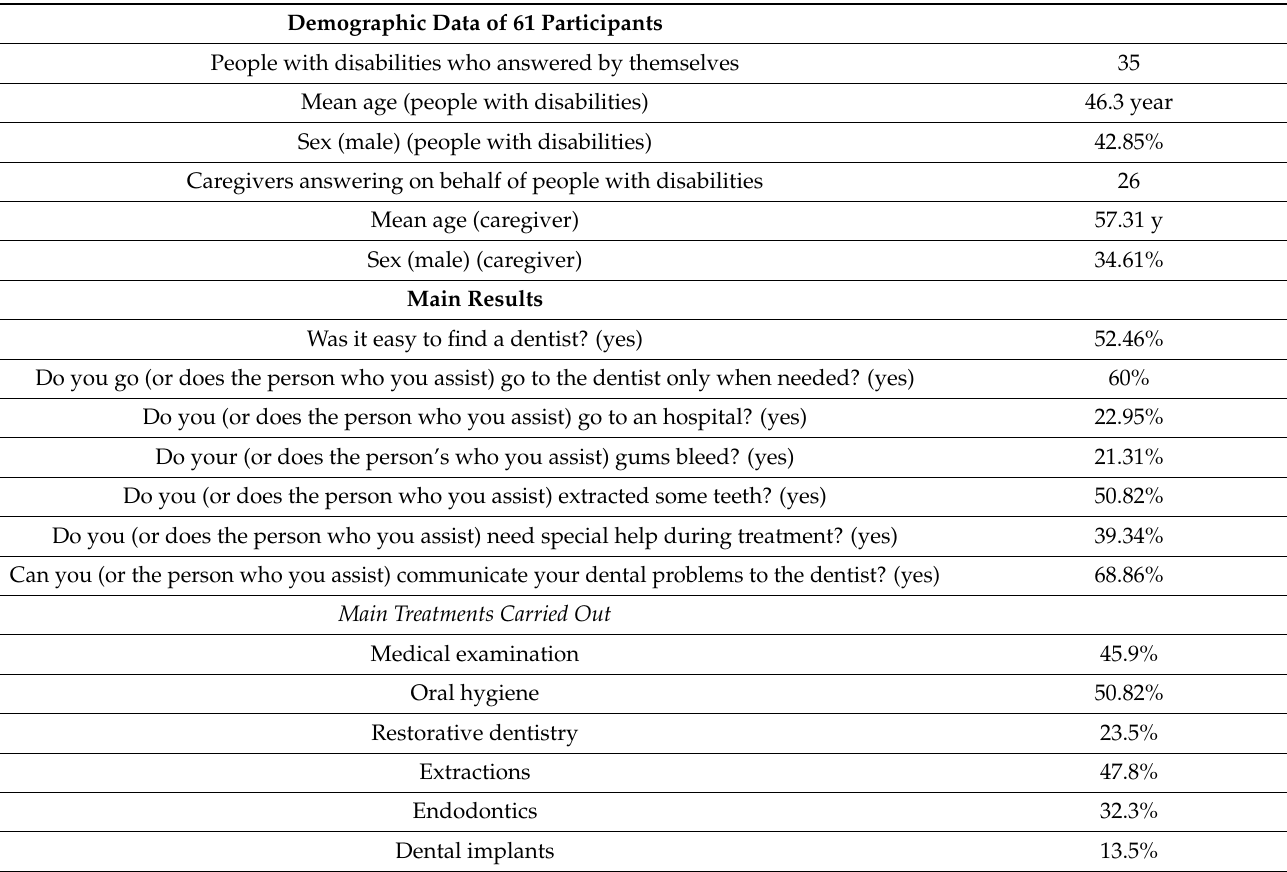
Table 2. Summary table of demographic data and main results obtained by administering questionnaires to people with disabilities and/or their